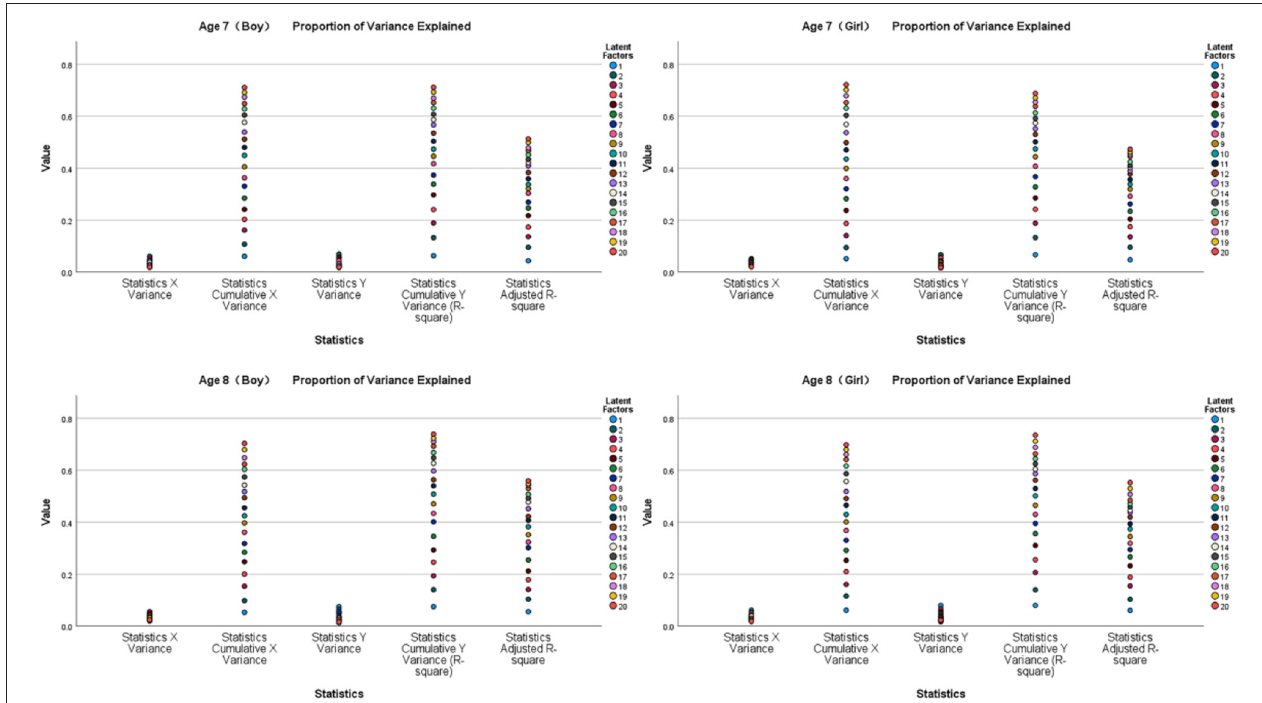
FIGURE 8 | Explanation and analysis of motor behavior on motor development.